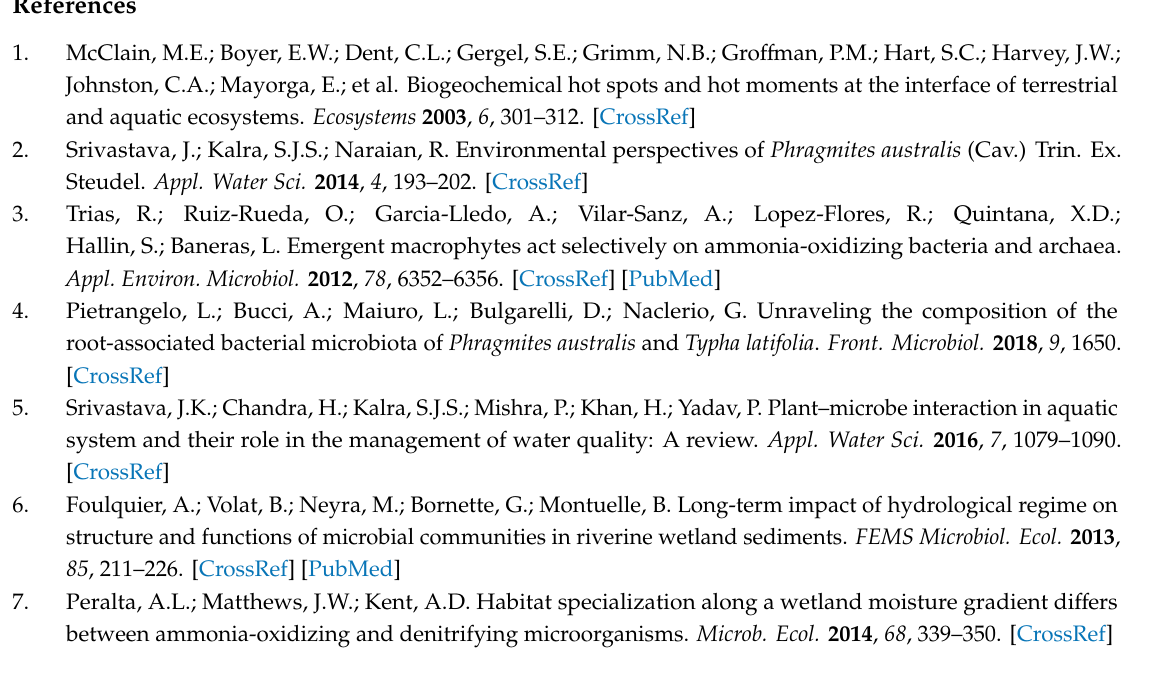
Supplementary Materials: The following are available online at http: // www.mdpi.com / 2073-4441 / 12 / 2 / 432 / s1. Figure S1: The relative abundance of di ff erent phyla and subphyla in the four zones. Abbreviations: Supralittoral zone with P. australis (RZa); eulittoral zone with P. australis (RZb); eulittoral zone without P. australis (NZc); infralittoral zone without P. australis (NZd). Table S1: The properties of local factors in lake riparian. Abbreviations: Supralittoral zone with P. australis (RZa); eulittoral zone with P. australis (RZb); eulittoral zone without P. australis (NZc); infralittoral zone without P. australis (NZd); ammonium nitrogen (NH 4 + ); nitrate nitrogen (NO 3 − ); sample water content (SWC); organic matter content (OM); total carbon (TC); total nitrogen (TN); dissolved organic carbon (DOC). Table S2: Estimated OUT richness and alpha diversity indices of the four zones (no significant di ff erence was found for each variable). Abbreviations: Supralittoral zone with P. australis (RZa); eulittoral zone with P. australis (RZb); eulittoral zone without P. australis (NZc); infralittoral zone without P. australis (NZd). Table S3: Permutational multivariate analysis of similarity (ANOSIM) and permutational multivariate analysis of variance (ADONIS) based on Bray–Curtis dissimilarity matrix (BC) and Weighted UniFrac dissimilarity matrix (WU) in bacterial community composition among four sampling sites. Abbreviations: P. australis zone (RZ); non-P. australis zone (NZ); supralittoral zone with P. australis (RZa); eulittoral zone with P. australis (RZb); eulittoral zone without P. australis (NZc); infralittoral zone without P. australis (NZd). Table S4: Significance analysis of RDA by Monte Carlo permutation (permutation = 999). Abbreviations: Ammonium nitrogen (NH 4 + ); nitrate nitrogen (NO 3 − ); sample water content (SWC); organic matter content (OM); total carbon (TC); total nitrogen (TN); dissolved organic carbon (DOC). Table S5: Module hubs and connectors in P. australi zone and non- P. australis zone networks. Abbreviations: P. australi zone (RZ); non- P. australis zone (NZ); c, o, f, g represent class, order, family, and genus, respectively. Table S6: The mantel and partial mantel tests on connectivity of networks and local factors. Abbreviations: P. australi zone (RZ); non- P. australis zone (NZ); ammonium nitrogen (NH 4 + ); nitrate nitrogen (NO 3 − ); sample water content (SWC); organic matter content (OM); total carbon (TC); total nitrogen (TN); dissolved organic carbon (DOC). Table S7: Correlations between module eigengenes and local factors. Abbreviations: P. australi zone (RZ); non- P. australis zone (NZ); ammonium nitrogen (NH 4 + ); nitrate nitrogen (NO 3 − ); sample water content (SWC); organic matter content (OM); total carbon (TC); total nitrogen (TN); dissolved organic carbon